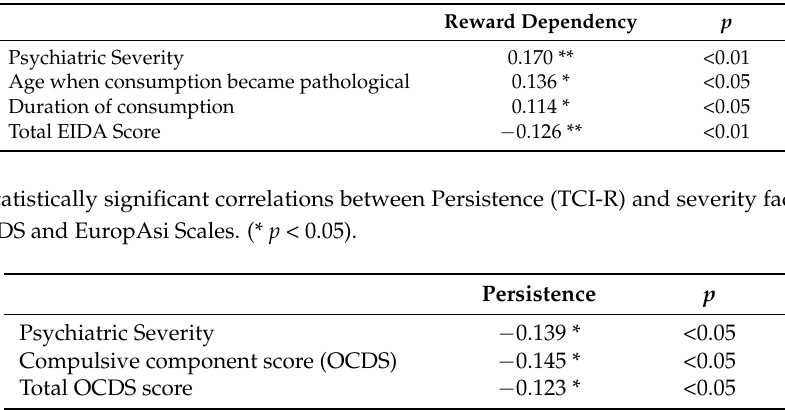
Table 3. Statistically significant correlations between Reward Dependency (TCI-R) and severity factors of the EIDA, OCDS and EuropAsi scales. (* p < 0.05; ** p < 0.001).